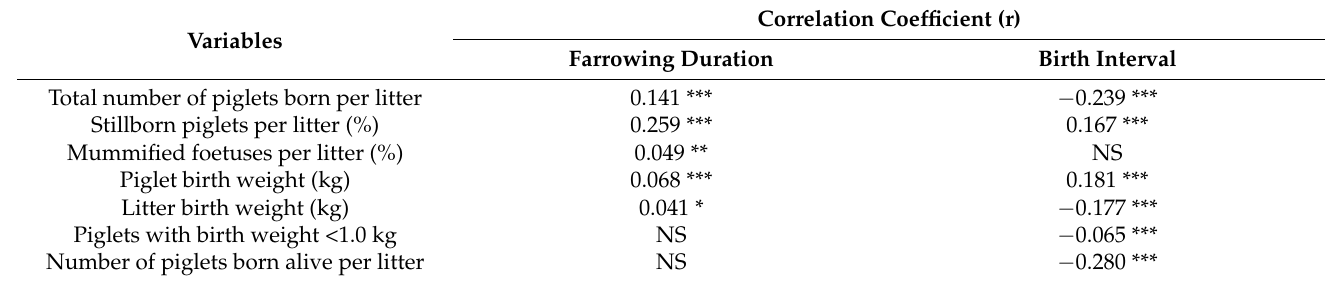
Table 2. Pearson’s correlations between farrowing duration (mean ± SD = 221.0 ± 119.3 min),